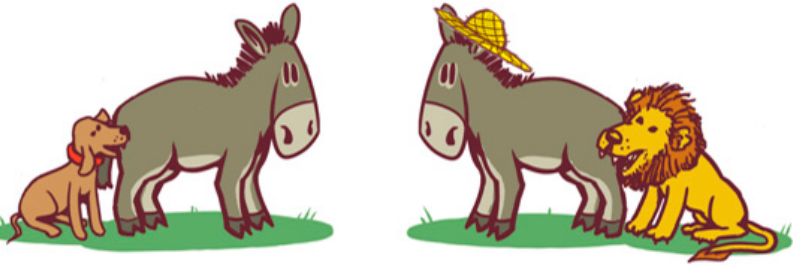
Figure 2. Modifying the patient of an action.